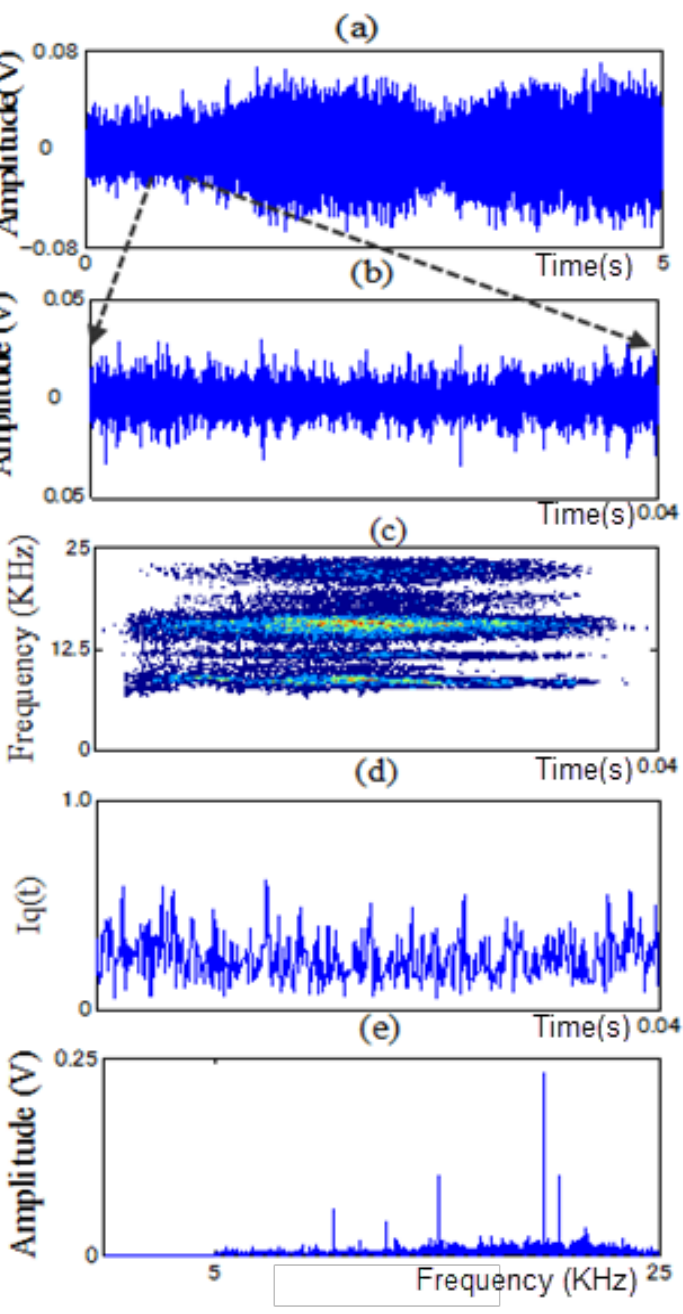
Figure 11. Contour graph and RCI of the spectra in the normal state: ( a ) time signal. ( b ) a part of time signal. ( c ) contour graph. ( d ) RCI and ( e ) power